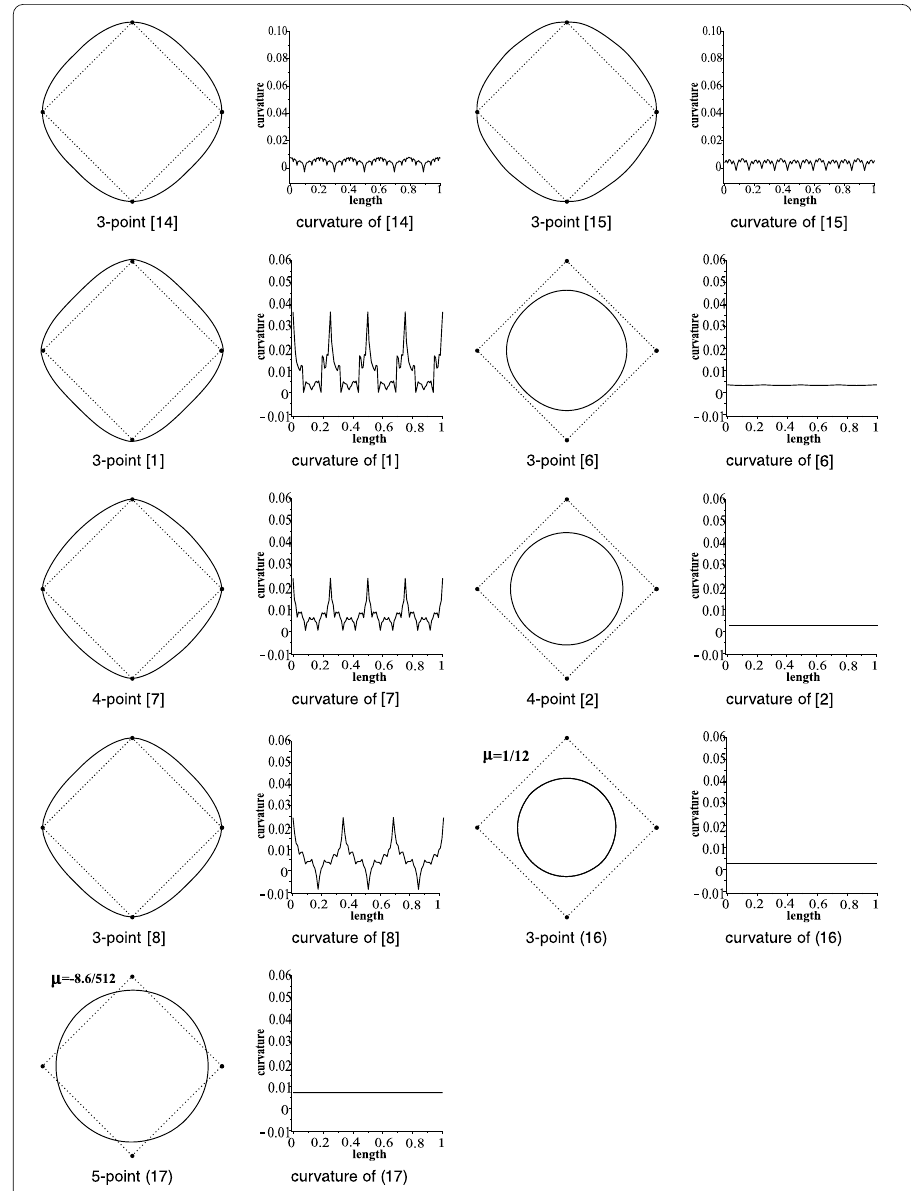
Figure 5 Comparison of existing and proposed SS when four control points are sampled from circle. Left: Limit curves obtained after the 5th iteration, the corresponding curvature is shown in the right column,